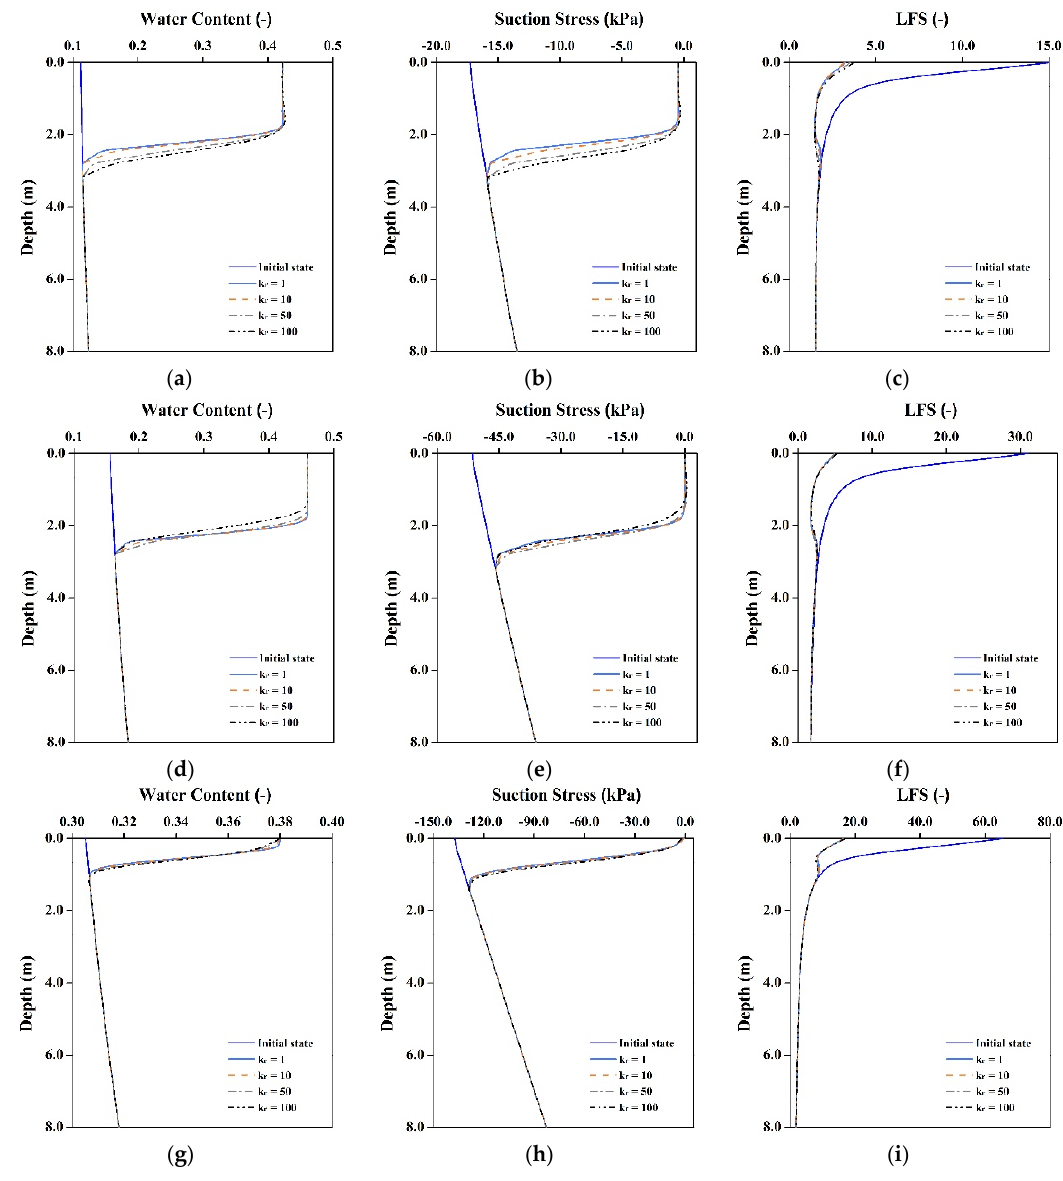
Figure 5. Results of rainfall infiltration in various hydraulic conductivity anisotropy cases at top of slope (X ‐ X’). Changes in ( a , d , g ) Water content; ( b , e , h ) Suction stress; and ( c , f , i ) LFS for loam, silt and clay slopes, respectively. ( a ) Loam; ( b ) Loam; ( c ) Loam; ( d ) Silt; ( e ) Silt; ( f ) Silt; ( g ) Clay; ( h ) Clay; ( i ) Clay.